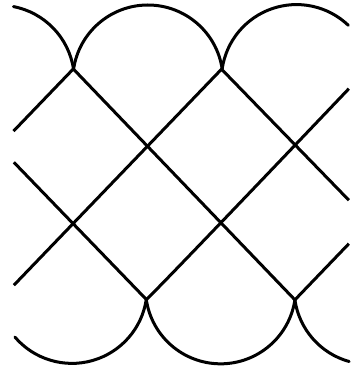
Figure 11. Woven mattress with n = 0.5 and 1.5,